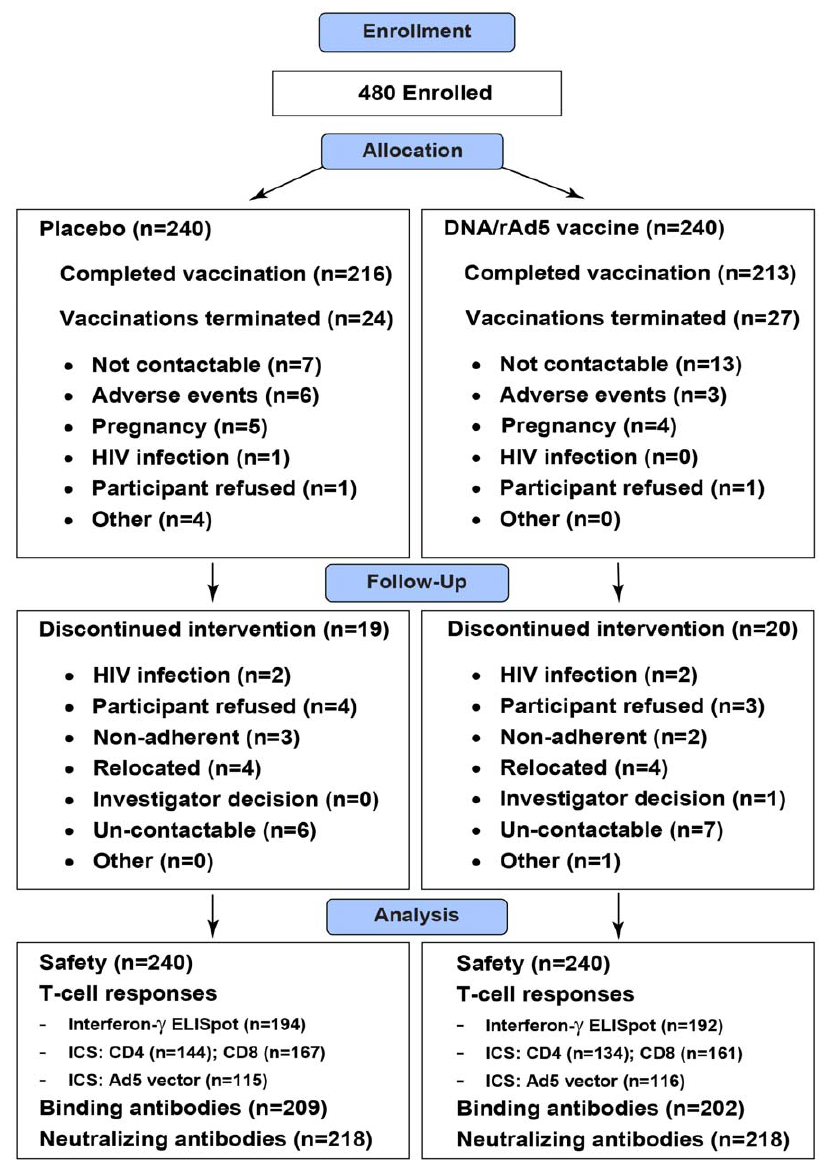
Figure 1. Number of individuals enrolled, randomized to vaccine or placebo, followed-up and analyzed. ICS=Intracellular cytokine staining, Ad5=Adenovirus serotype 5.